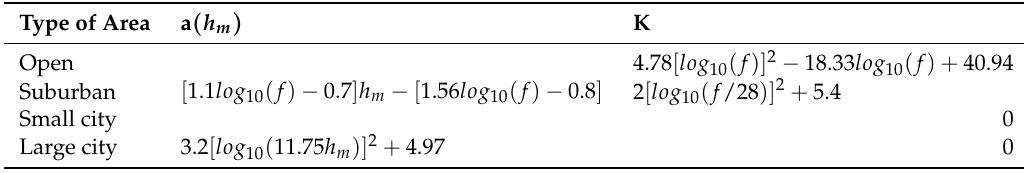
Table 2. List of a ( h m ) and K values for each type of area [54].